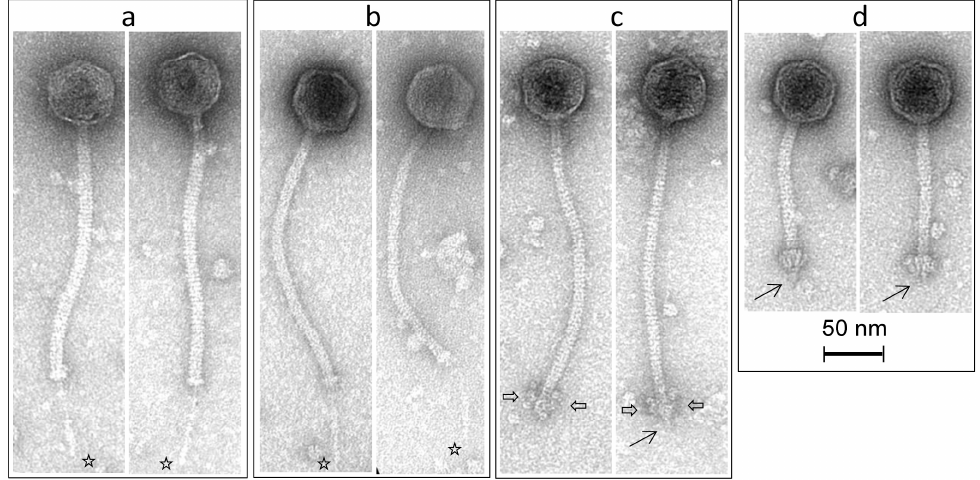
Figure 7. Transmission electron micrographs of representative phages belonging to the cos (SW11—panel A); pac (SW13—panel B); 5093 (SW27—panel C); and 987 groups (SW16—panel D). The presence of long tail fibers is indicated by a star (panels ( a , b )); globular appendages at the distal end of the 5093 phage are indicated by a double-sided arrow (panel ( c )); and short tail fibers are indicated by a single-lined arrow (panels ( c , d